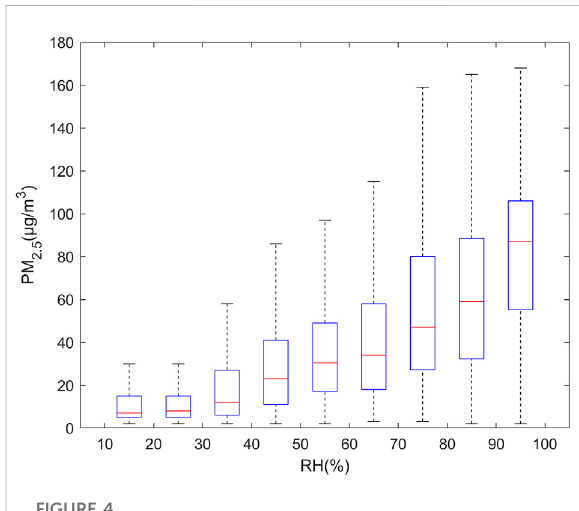
FIGURE 4 Relationship between PM 2.5 mass concentration and RH in the heating